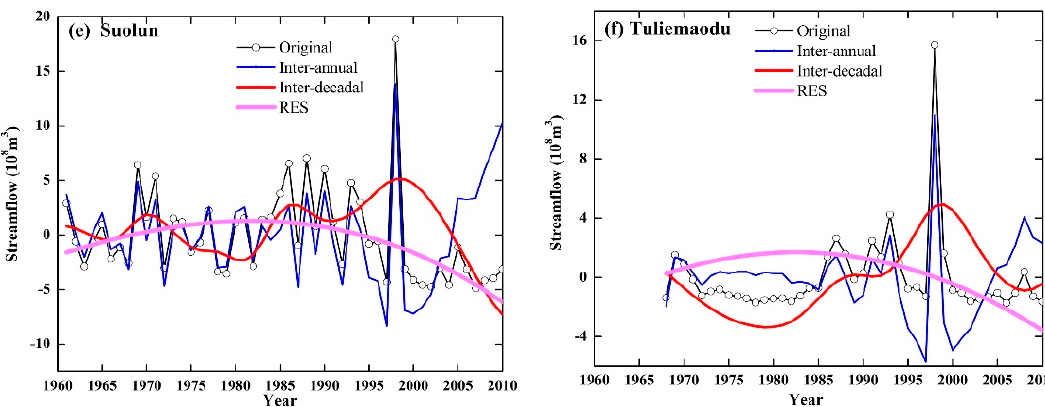
Figure 4. Inter-annual, inter-decadal and RES signals computed by EEMD method from annual streamflow anomalies at six gauge stations (( a ) Beian, ( b ) Shihuiyao, ( c ) Xiaoergou, ( d ) Zhalantun, ( e ) Suolun and ( f ) Tuliemaodu) during 1961–2010 in the headwater region of the Nenjiang River Basin, Northeast China.